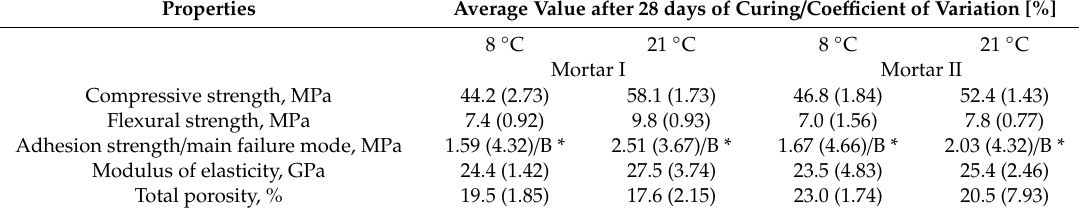
Table 4. The main properties of the tested repair mortars after curing in two temperatures: 8 ◦ C and 21 ◦